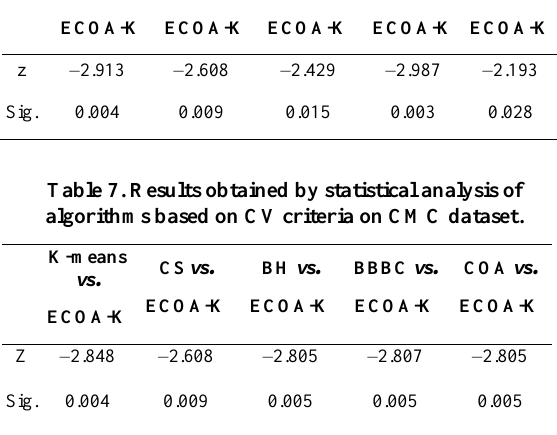
Table 6. Results obtained by statistical analysis of algorithms based on purity criteria on CMC dataset. K-means vs.